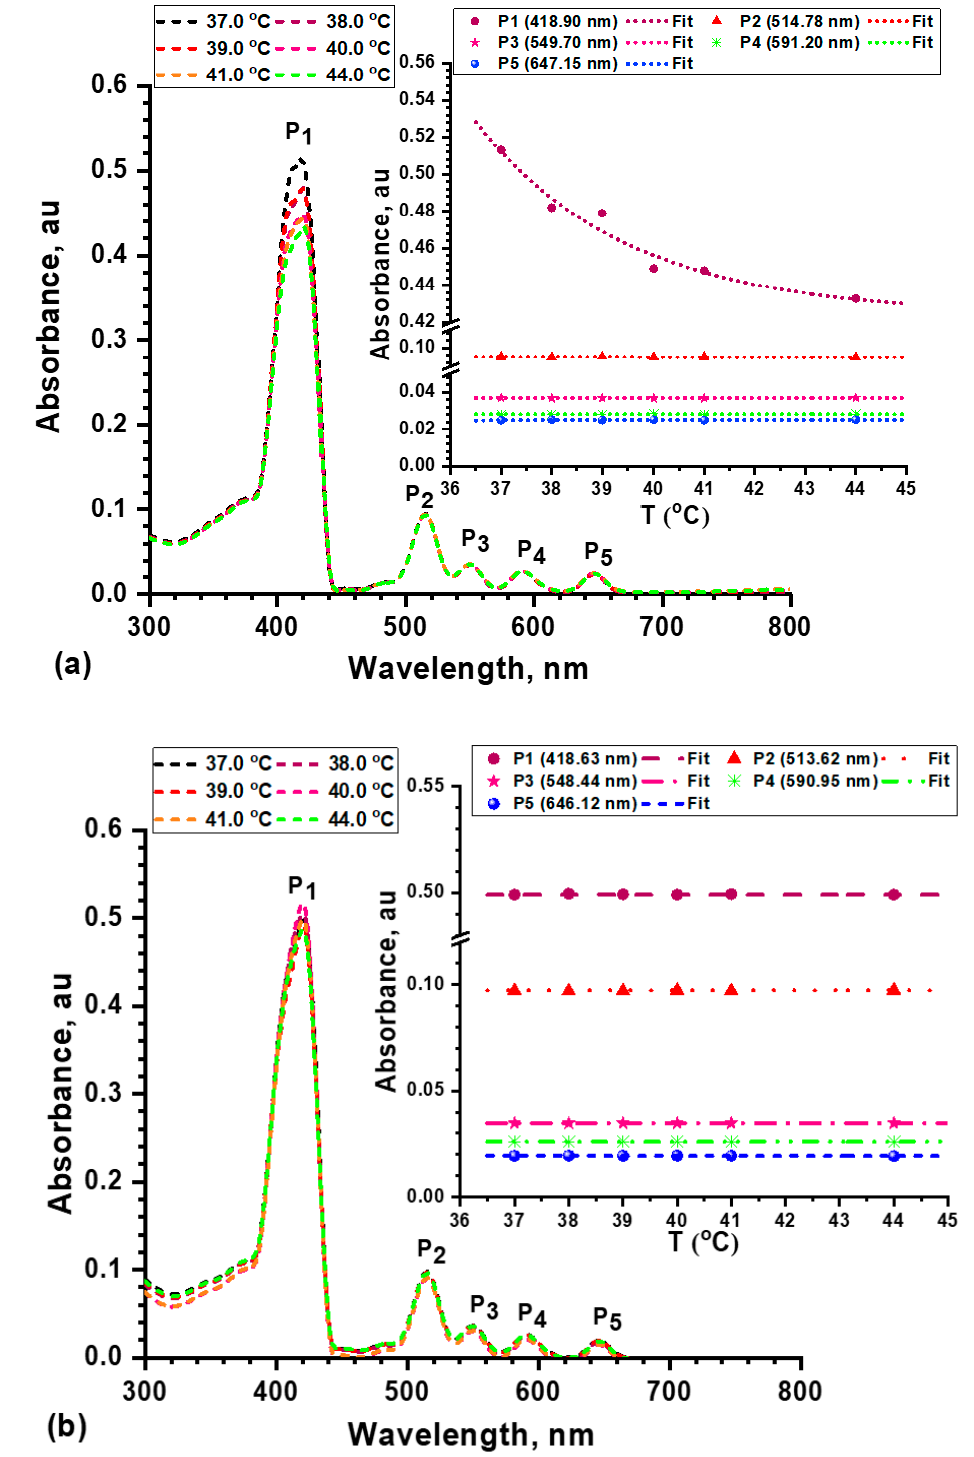
Figure 6. Absorption spectra (main curves) and the thermal stability of each peak (insert curves) of ( a ) porphyrin and ( b ) porphyrin nanocomposite at different temperatures.